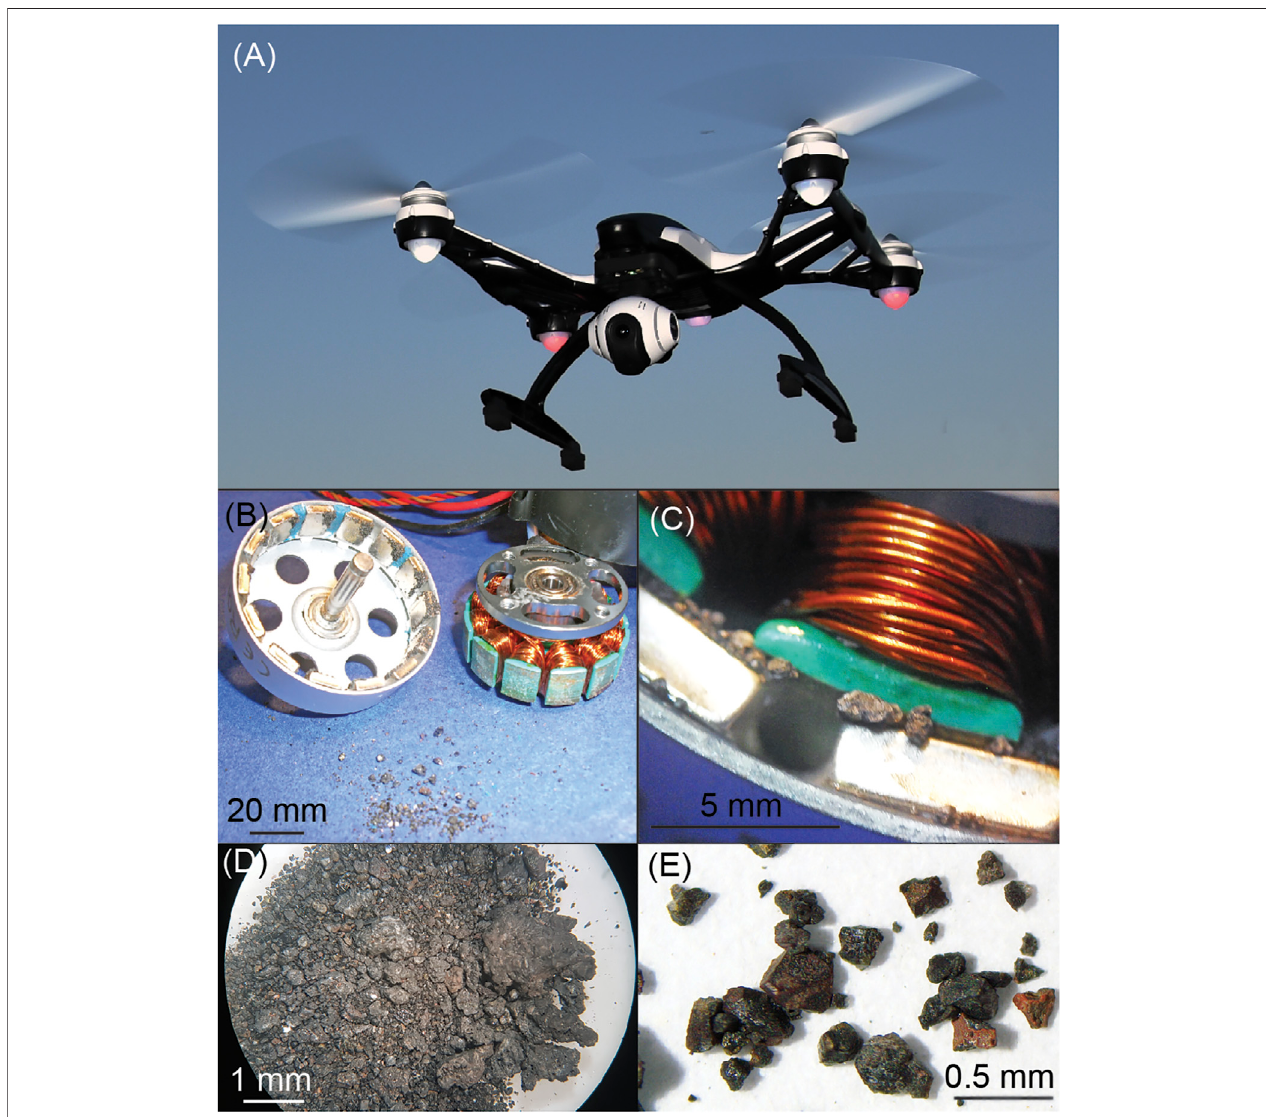
FIGURE 3 | (A) The sUAV deployed on Stromboli volcano featuring the 4K camera on its bottom side. (B) The disassembled motor showing the trapped volcanic material. (C) Close-upofthematerialtrappedinsidethemotorbetweenthemagnetsoftherotorandthecoilsofthestator. (D) Microscopyimageofthevolcanicmaterial retrieved fromonemotor.Grainsizesvaryfromsub-millimetricuptoafewmillimeters. (E) Close-upmagni fi cationoftitanomagnetitecrystals,whichconstitutepartofthe trapped volcanic material inside the motors.